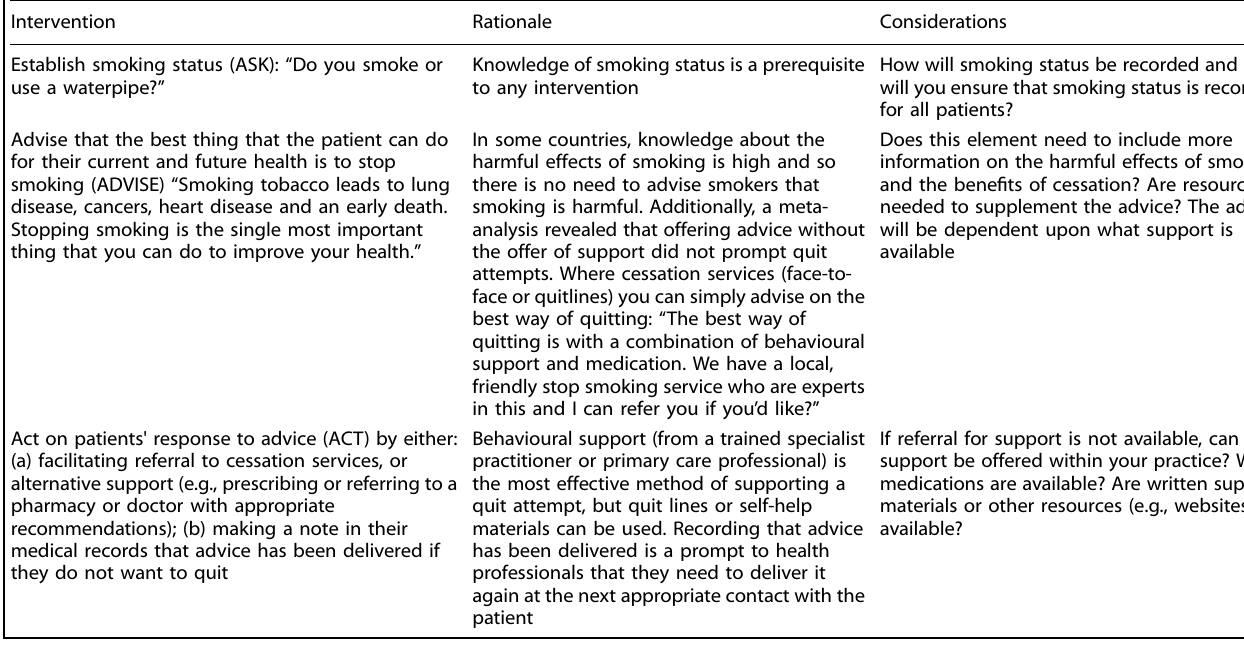
Table 3. Adapting Very Brief Advice on Smoking to your context Intervention